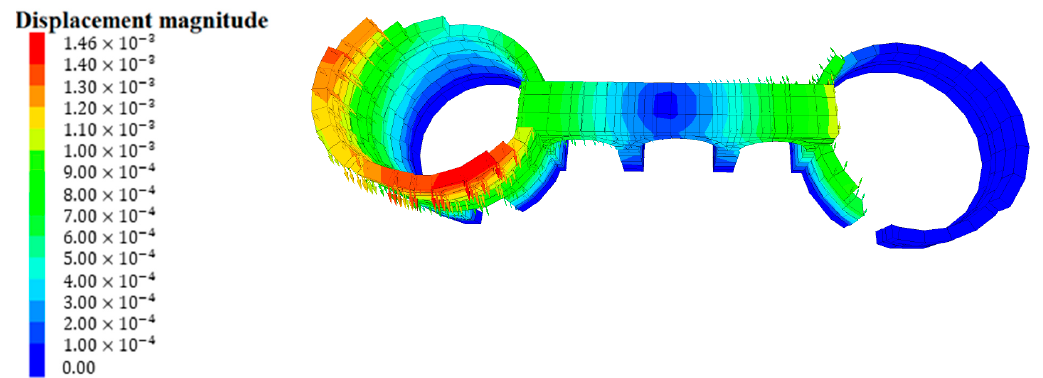
Figure 9. Eigenmode 3 . Figure 9. Eigenmode